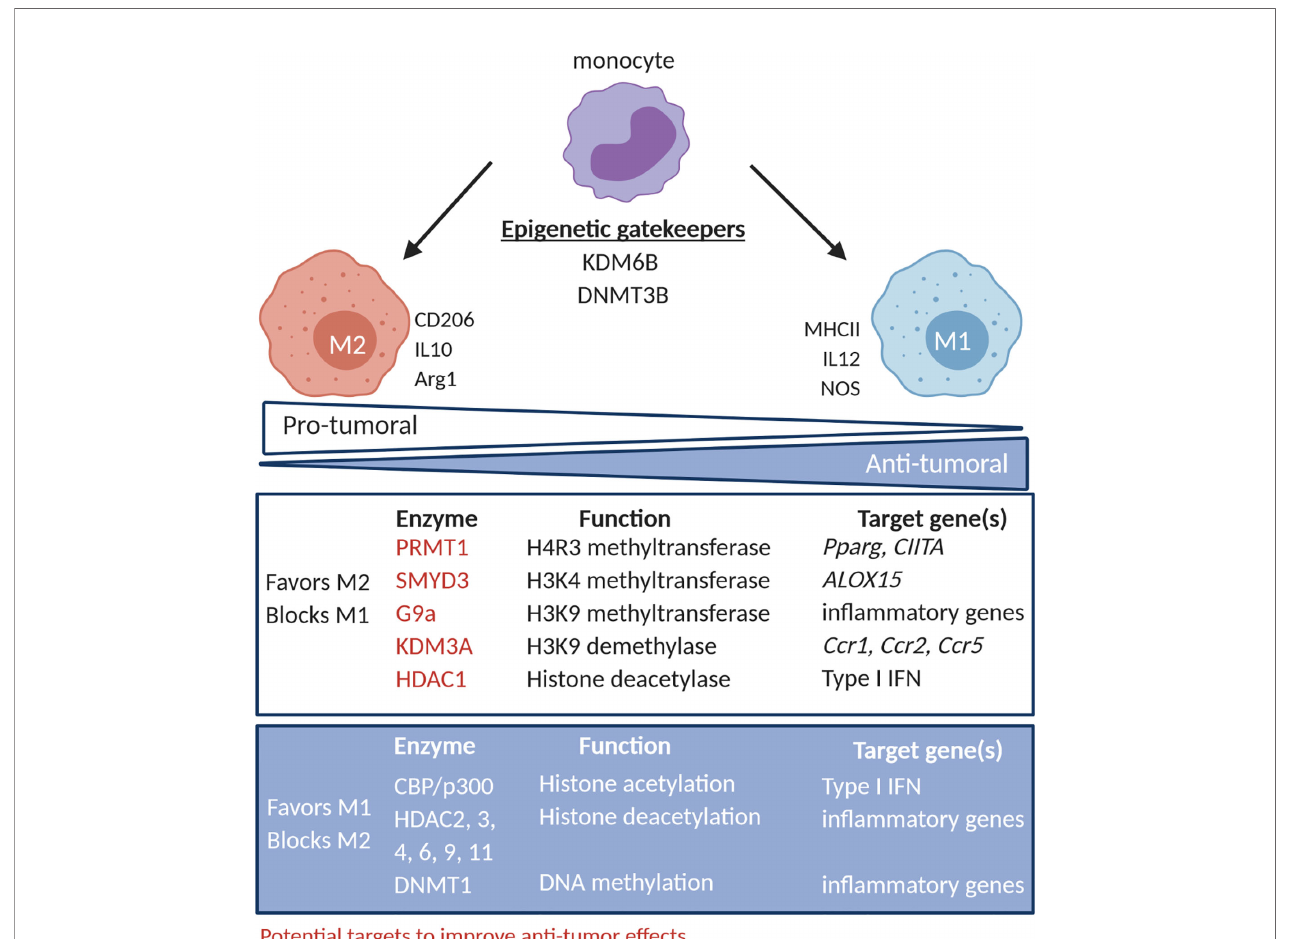
FIGURE 1 | TAM polarization and its epigenetic regulatory networks. The activity of epigenetic regulators has been correlated to the phenotype and function of TAM. PRMT1, SMYD3, G9a (HMT) KDM3A (HDM) and HDAC1 promote TAM with an M2-like phenotype (CD206) and function (IL10 and arg-1), while CBP/p300 (HAT), HDAC2, 3, 4, 6, 9, 11 and DNMT1 promote TAM with an M1-like phenotype (MHC-II) and function (IL12, NOS). DNMT3B and KDM6B (HDM) seem to act as gatekeepers and can in certain conditions promote M1- or M2-like behavior. PRMT1, SMYD3, G9a, KDM3A and HDAC1 represent potential targets to improve increase the M1/M2 balance. HMT, histone methyltransferase; HDM, histone demethylases; HAT, histone deacetylase; HDAC, histone